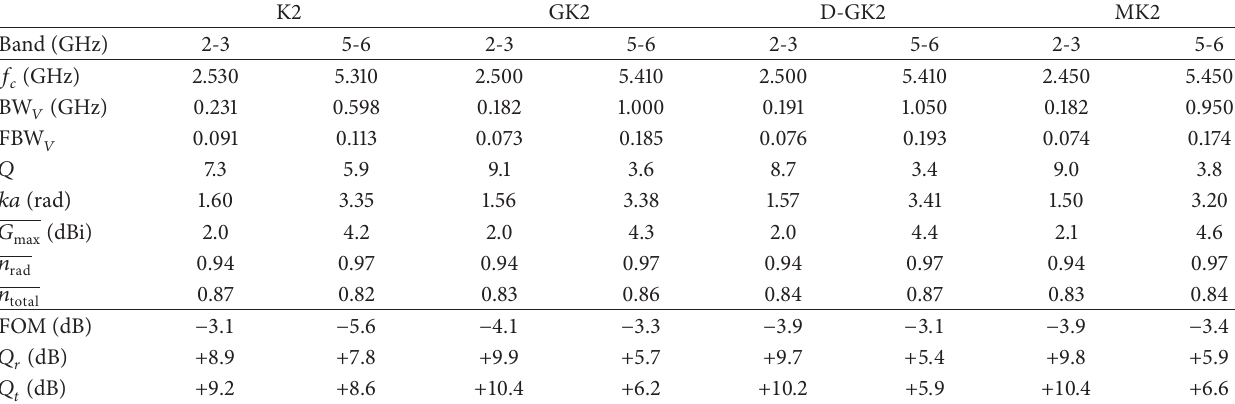
Table 4: Comparison of electrical performance between the four dual-band printed IFAs in each frequency